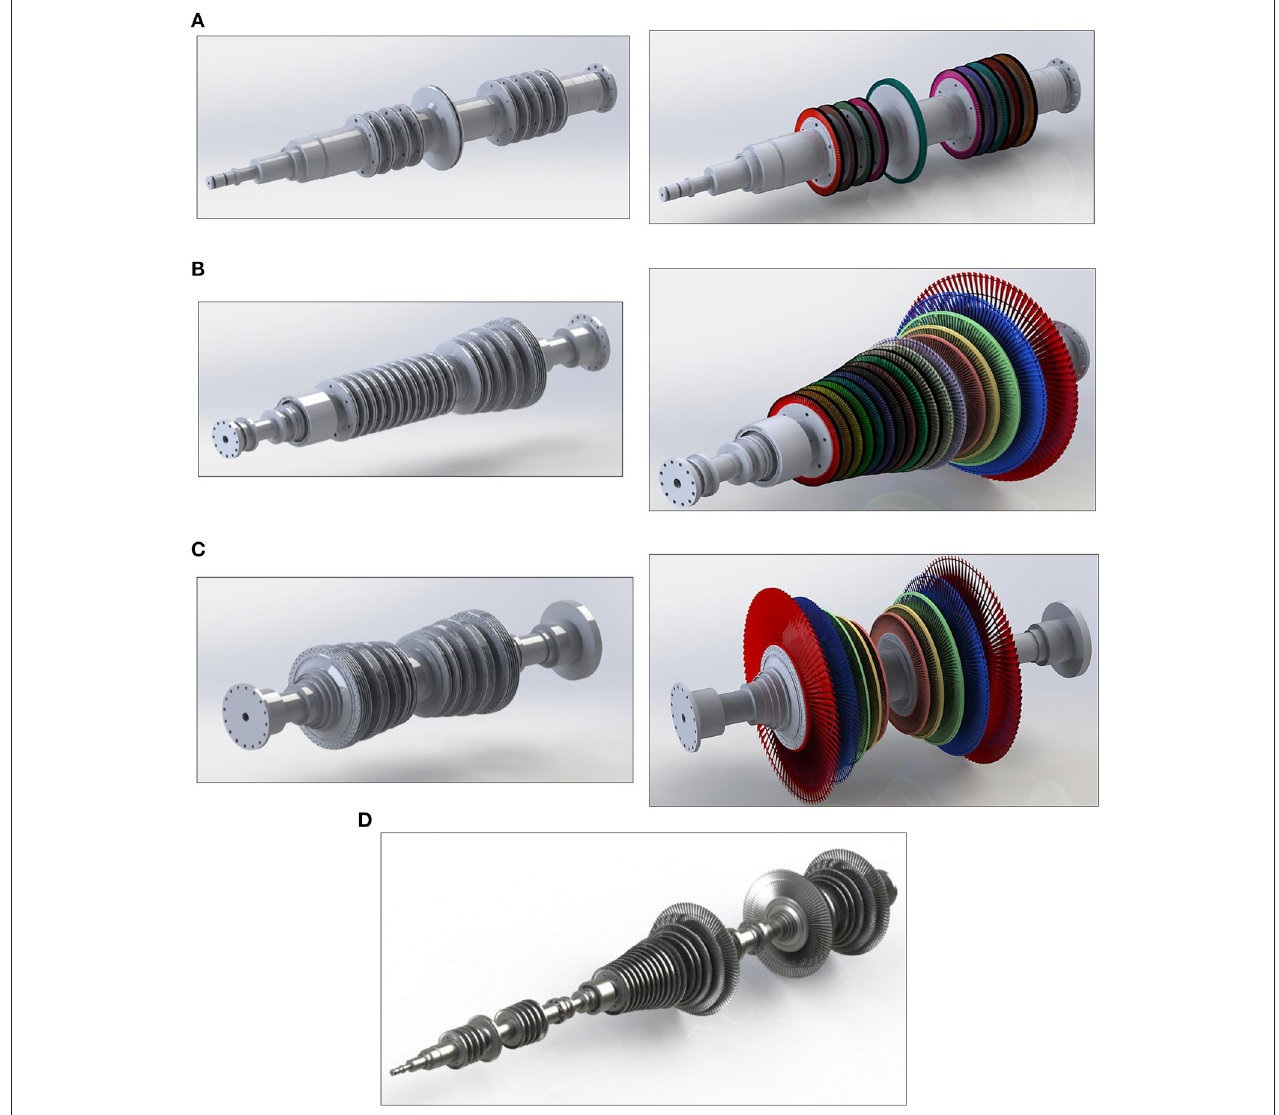
FIGURE 4 | (A) Rotor shaft and complete 3D CAD assembly of the high pressure turbine. (B) Rotor shaft and complete 3D CAD assembly of the intermediate pressure turbine. (C) Rotor shaft and complete 3D CAD assembly of the low pressure turbine. (D) Final 3D CAD of the complete steam turbine.